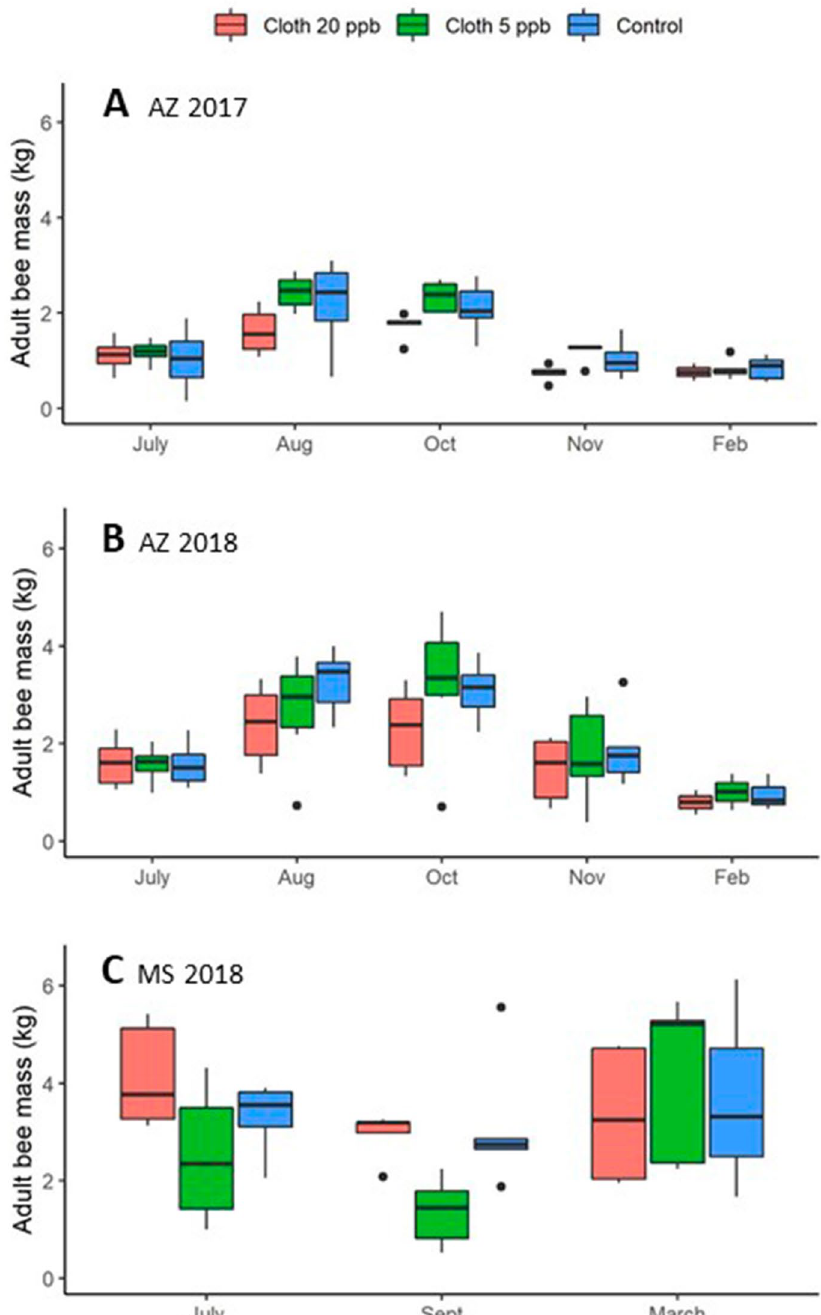
Figure 2. Average adult bee mass (kg) per colony for each of 3 treatment groups: Clothianidin 20-ppb (orange), clothianidin 5-ppb (green), control (blue). ( A ) AZ 2017; ( B ) AZ 2018; ( C ) MS 2018. Boxes are defined as 1.58 * IQR/n 0.5 , where IQR is the inter-quartile range and n is the number of data